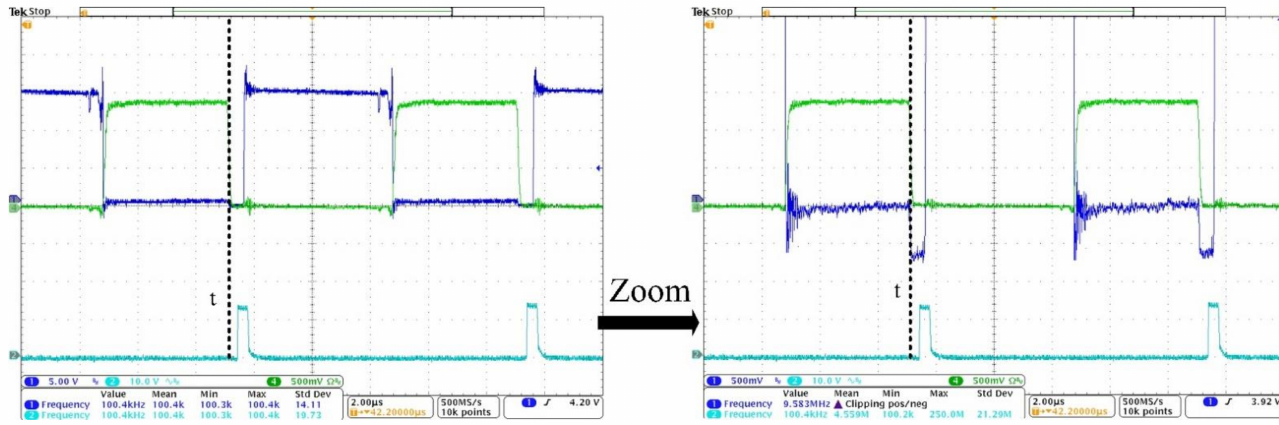
Figure 19. Waveforms of the SR driving signals without the proposed technique. As shown in Figure 20, with the proposed adaptive SR driving technique, the PWM width is adjusted. It is clear that the new PWM width is more suitable, and the comparator output no longer detects the phenomenon wherein the current passes through the body diode because the switch is turned off early.